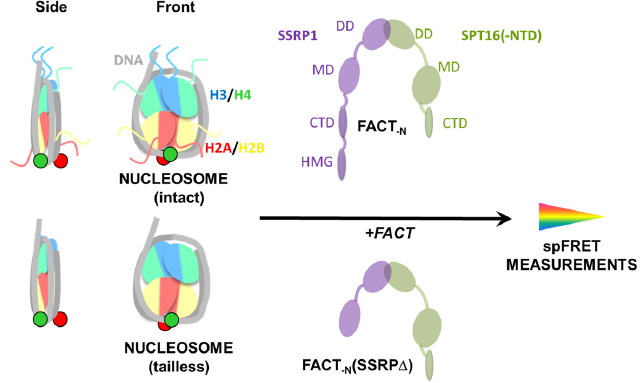
Figure 1. Experimental approach for analysis of the effect of human FACT on nucleosome structure and